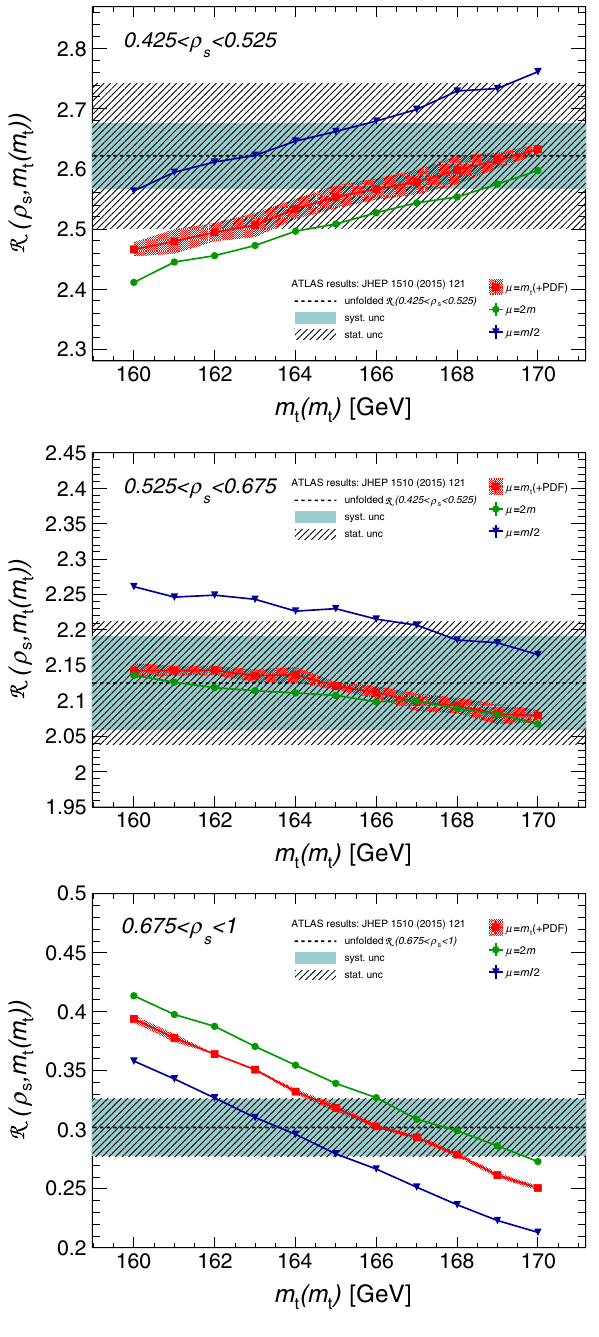
Fig. 3 Same as Fig. 2 but for the ρ s > 0 . 425 intervals